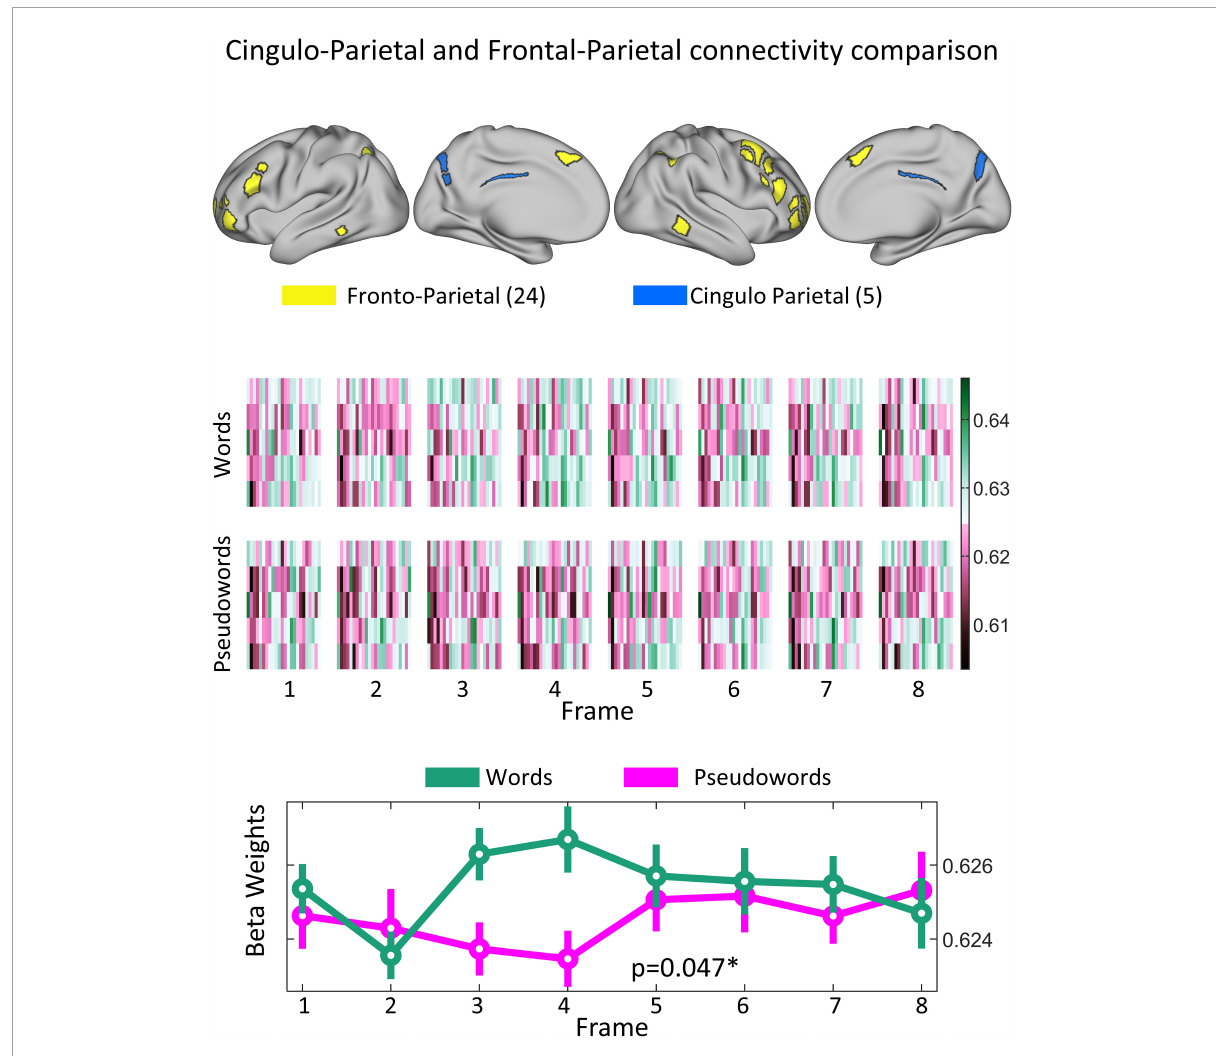
FIGURE5 Significant difference observed in how the Cingulo–Parietal and Fronto–Parietal networks interact due to both progression of task and stimulus type. (Top panel) Shows the topological representation of cortical areas for both the Fronto-Parietal (yellow) and Cingulo Parietal (blue) networks. (Middle panel) Shows the mean sub-connectivity matrices between all the Cingulo Parietal and Fronto-Parietal ROIs (5 × 24 matrices) across participants for each stimuli (Word vs. Pseudowords) and each frame. The (Bottom panel) shows the distribution of marginal means of connectivity values for each frame and stimuli for connections belonging to the Fronto–Parietal and Cingulo–Parietal networks. Mean values shown as a circle and the dispersion is indicated with a bar covering 1.15 times the standard error of the connectivity values. When testing for how these values changed across frame and stimuli type, this functional system pair was found to be significant with a corrected p -value of